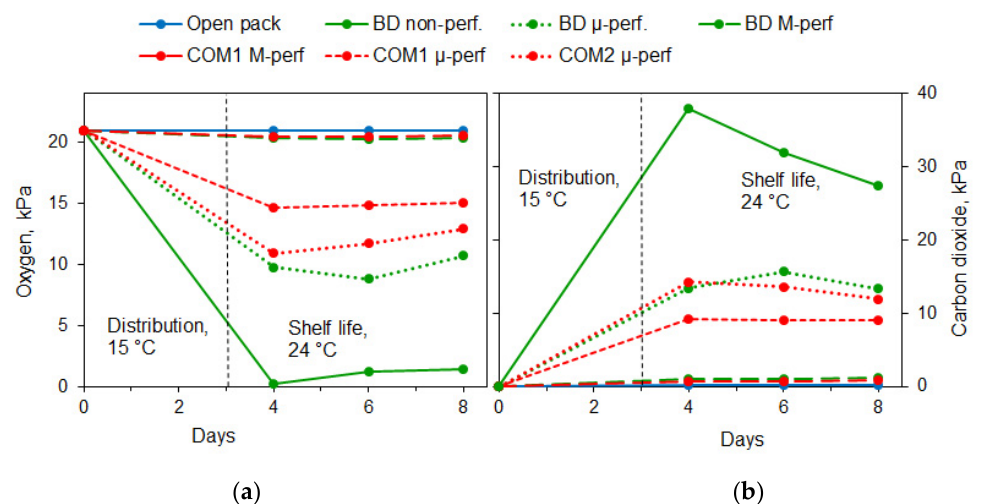
Figure 2. Headspace oxygen (a) and carbon dioxide (b) levels in banana packages during simulated distribution at 15 °C and shelf life/home storage at 24 °C. Package types: control (Open pack), non- perforated, micro- and macro-perforated biodegradable packages (BD non-perf., BD µ-perf. and BD M-perf., resp.), macro-and micro-perforated commercial CPP packages (COM1 M-perf. and COM1 µ-perf., resp.), and micro-perforated commercial PA-based package (COM2 µ-perf.).